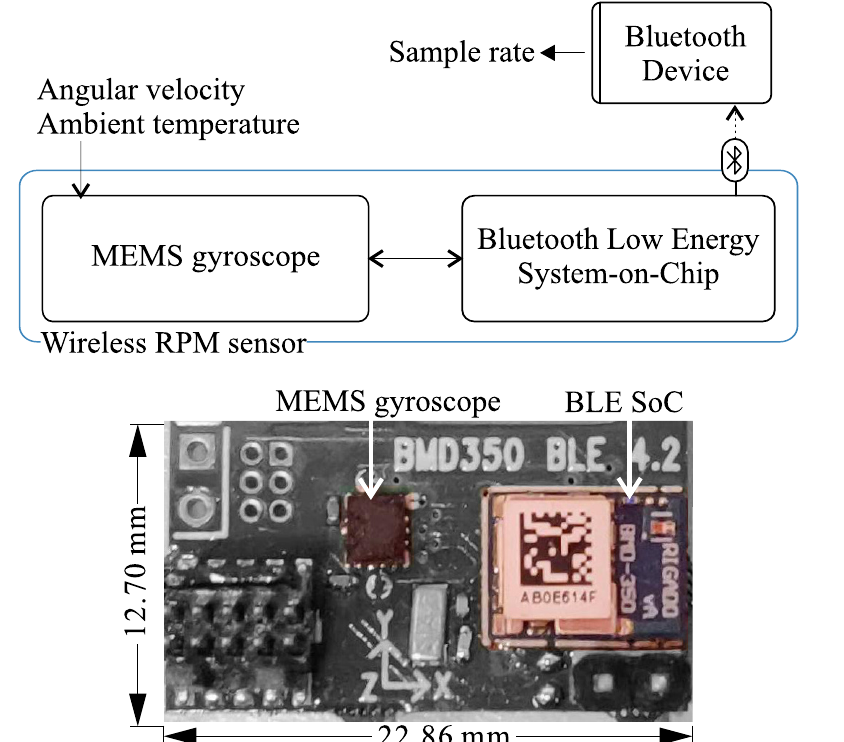
Figure 5. Block diagram of the wireless RPM sensing system ( top ), and the sensor node implementa- tion ( bottom ), including a Bosch BMG250 MEMS gyroscope and a Rigado BMD350 module based on a Nordic Semiconductor nRF52832 SoC.